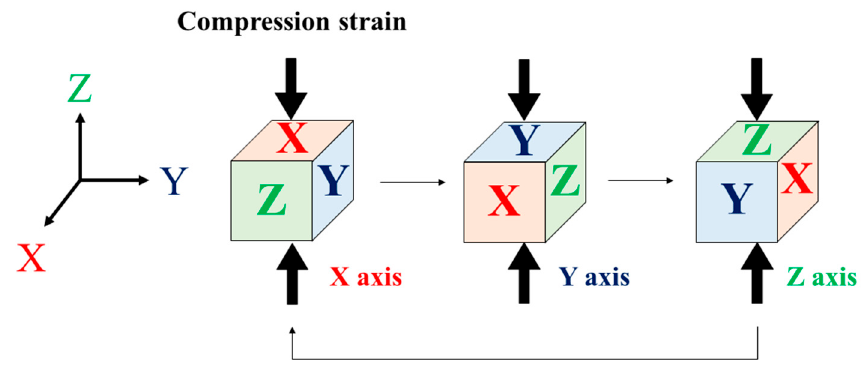
Figure 1. Schematic illustration of the multi-directional forging (MDF) method. The forging direction was changed by 90 degrees pass by pass.